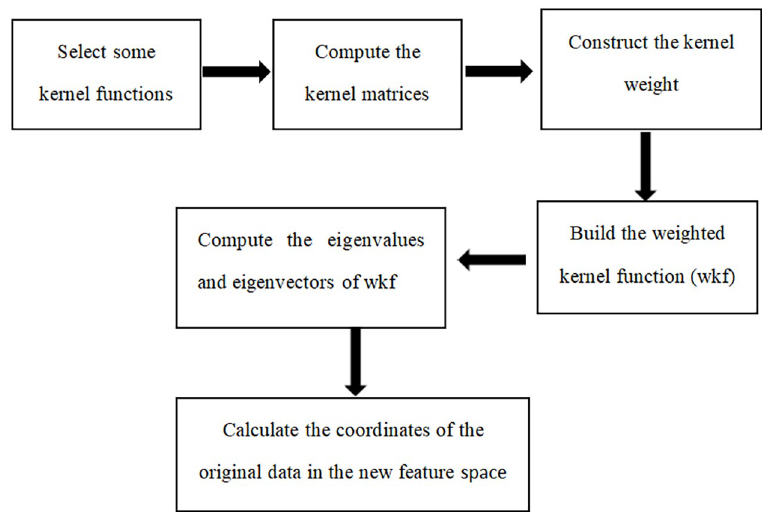
Fig 2. The frame of the WKPCA dimension reduction